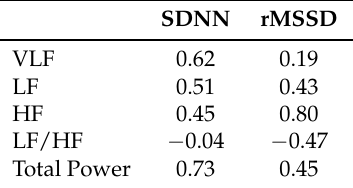
Table 3. Spearman’s rank correlation coefficient between HRV features in 5 min time series.